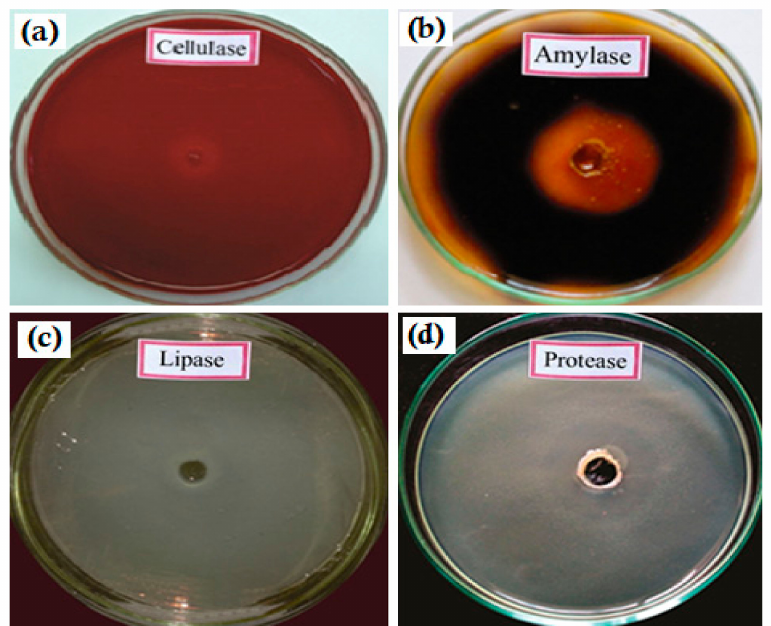
Figure 6. Hydrolysis activity of Xylaria sp in LDPE. Secretion of depolymerise in the GYP medium by Xylaria sp (xtc 1) when grown on media containing ( a ) cellulase; ( b ) caesinase; ( c ) lipase and ( d ) gelatinase respectively, as seen by the zones of